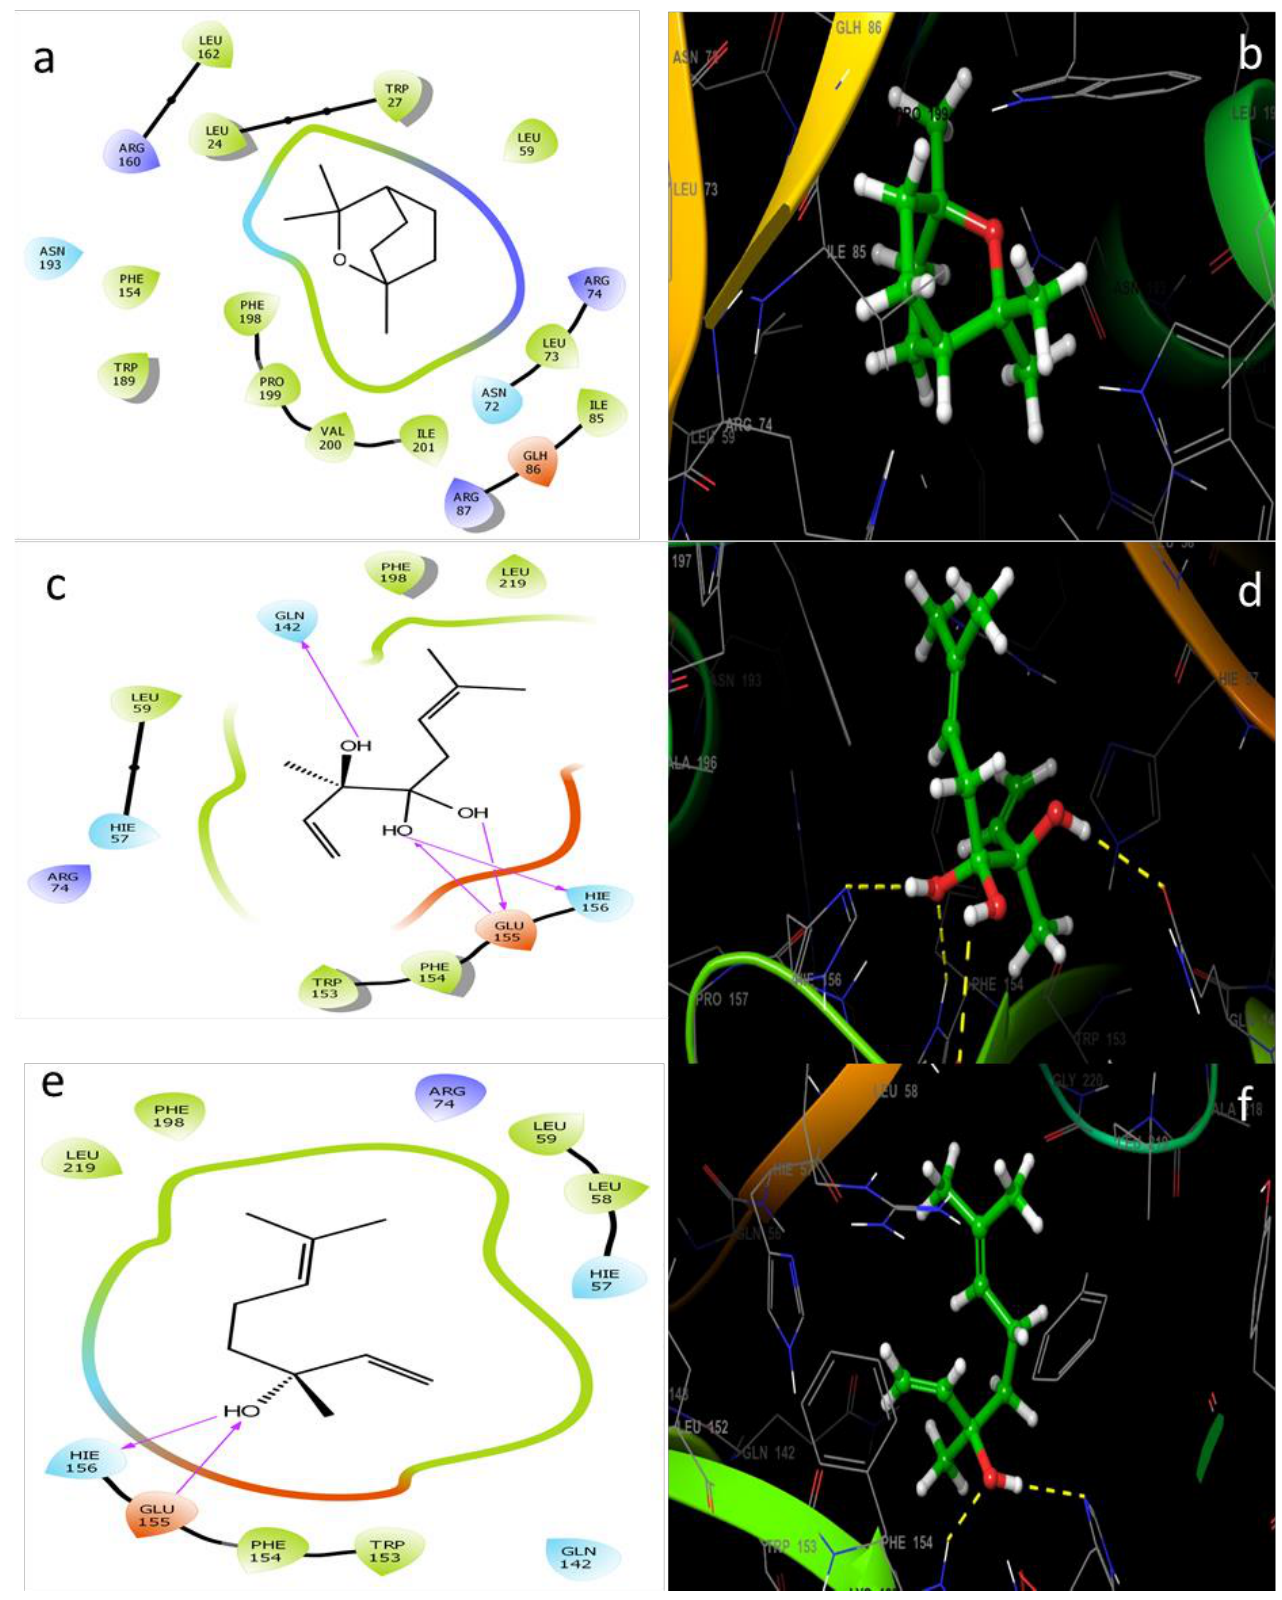
Figure 2. Intermolecular interactions 2D and 3D between ( a , b ) eucalyptol with E. coli 1VLY protein, ( c , d ) Linalyl acetate with E. coli 1VLY protein, ( e , f ) Linalool with E. coli 1VLY protein.